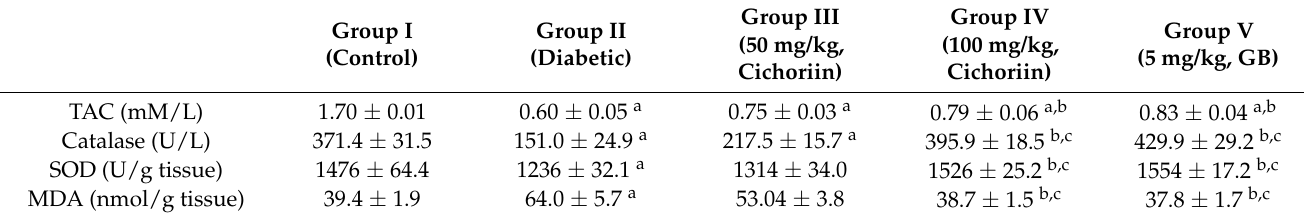
Table 2. Effect of cichoriin on oxidative stress